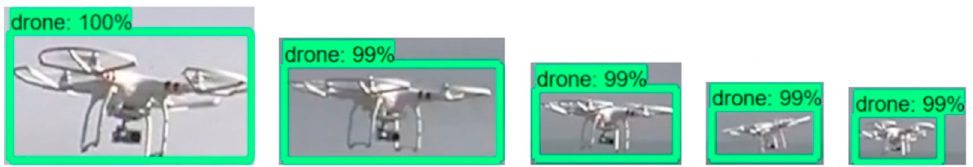
Figure 20. Drone Figure 20. Drone sizes. Figure 20. Drone sizes.